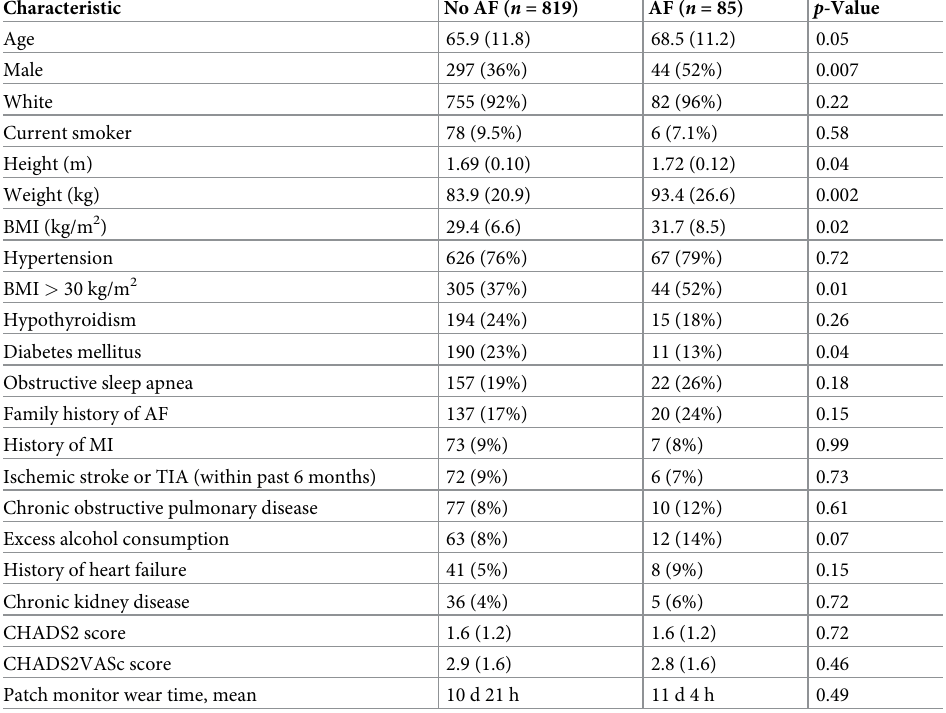
Table 2. Baseline characteristics. Characteristic